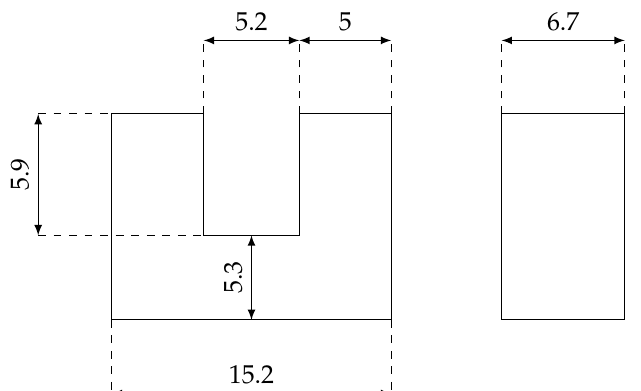
Figure 10. Geometrical dimensions of each C-ferrite adopted in the reduced-size prototype. Quotes are reported in